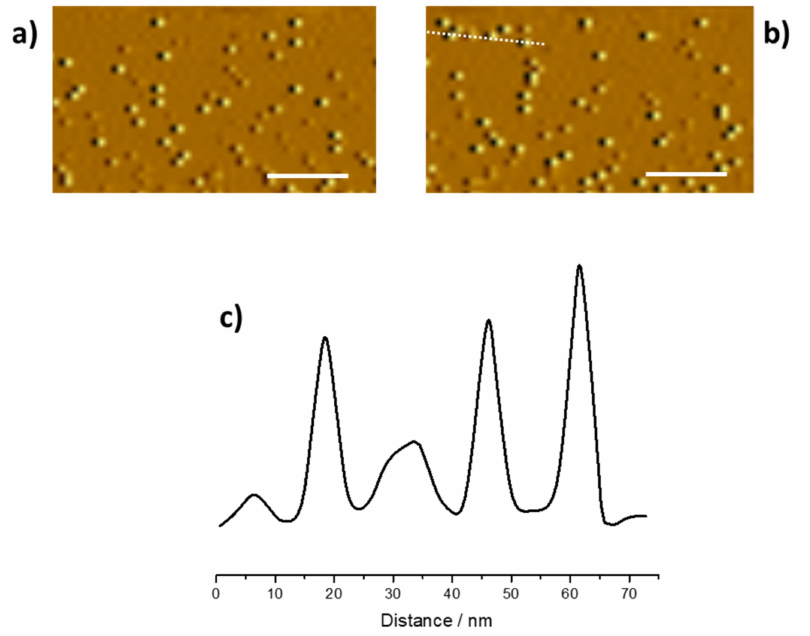
Figure 4. AFM images of the CNPs ( a ) as synthetized and ( b ) after acid treatment (pH 4.5 for 1 h). The bar in the figures is 50 nm wide. Image ( c ) reports the carbon dots z-profiles related to image CNPs in image ( b ) crossed by the white